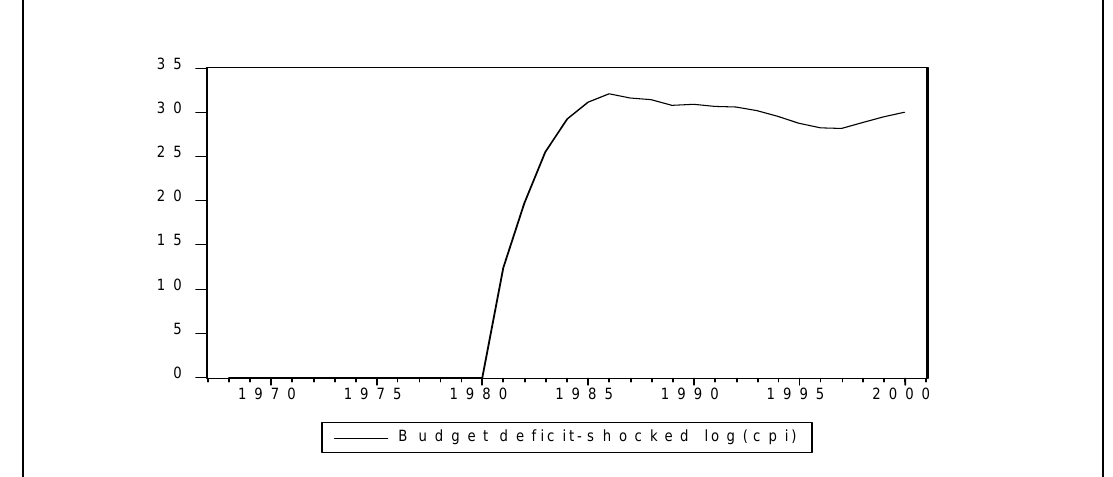
Figure 2 Dynamic adjustment properties on CPI due to a 10 per cent increase in the budget